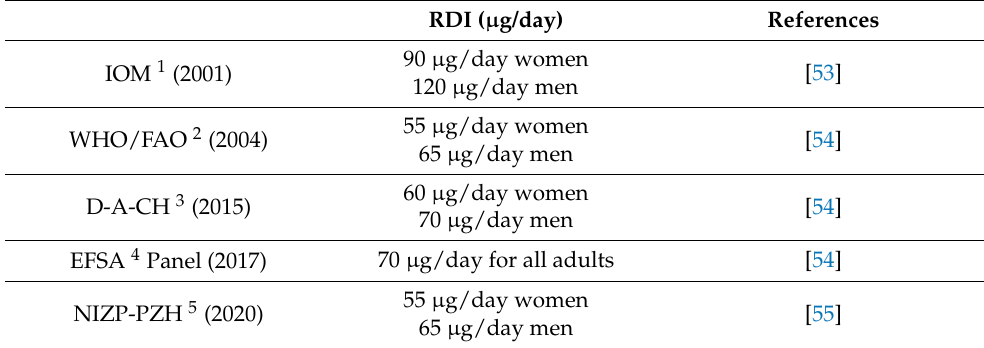
Table 1. Recommended Daily Intake of Vitamin K for Adults.